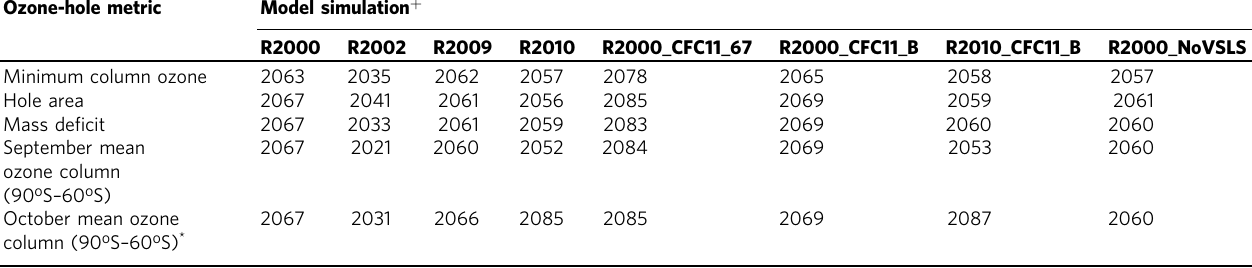
Table 2 Dates for return to 1980 values for different ozone-hole metrics for 3D model simulations. Ozone-hole metric